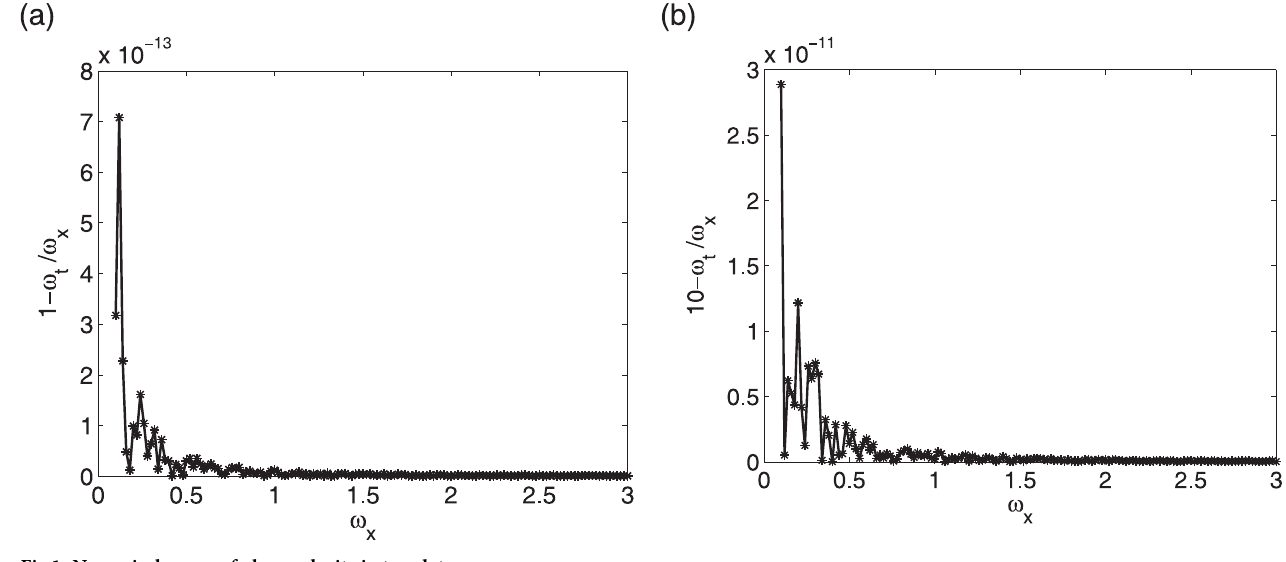
Fig 1. Numerical errors of phase velocity in two data